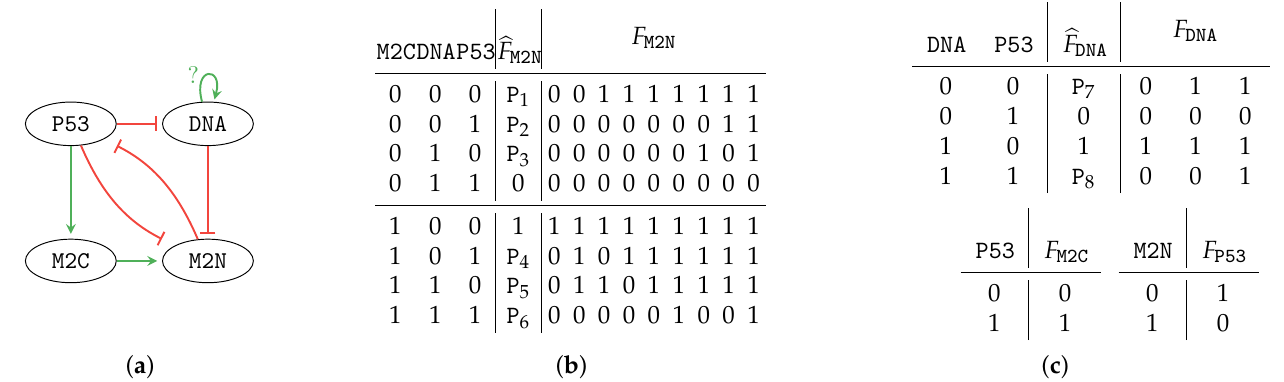
Figure 3. ( a ) A regulatory network of a simplified ParBN similar to one in Figure 1a. Compared to the previous case, we do not know whether regulation ( DNA , DNA ) is observable. ( b ) All possible valid update functions F M2N satisfying the static constraints (monotonicity, observability). ( c ) Valid update functions F DNA , F M2C and F P53 satisfying the static constraints. Here, P i denote the parameters ( ) of the ParBN. P